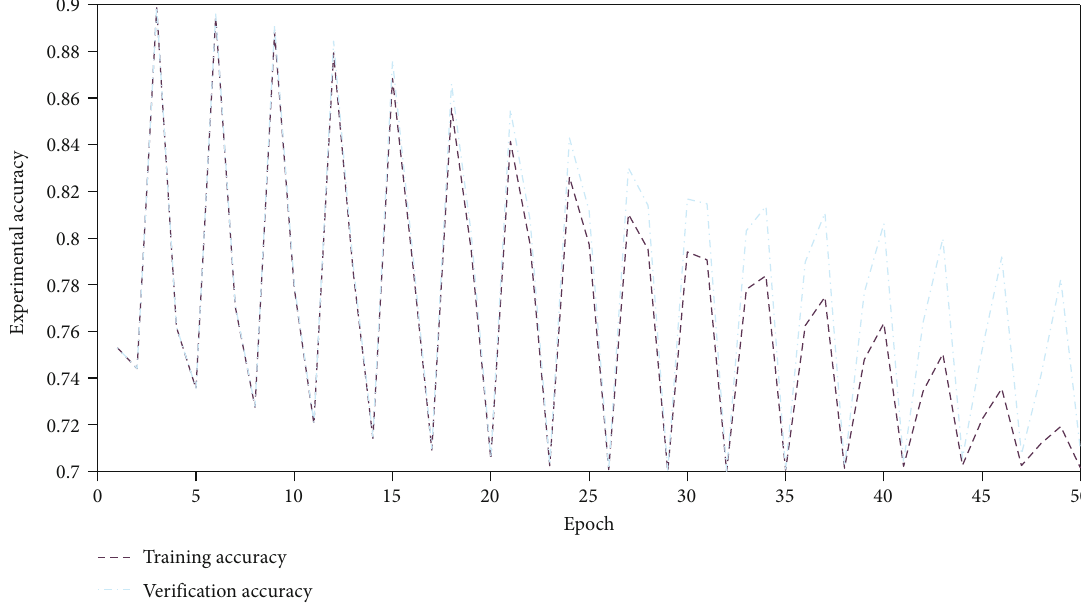
Figure 4: Accuracy of lowercase letter images in English